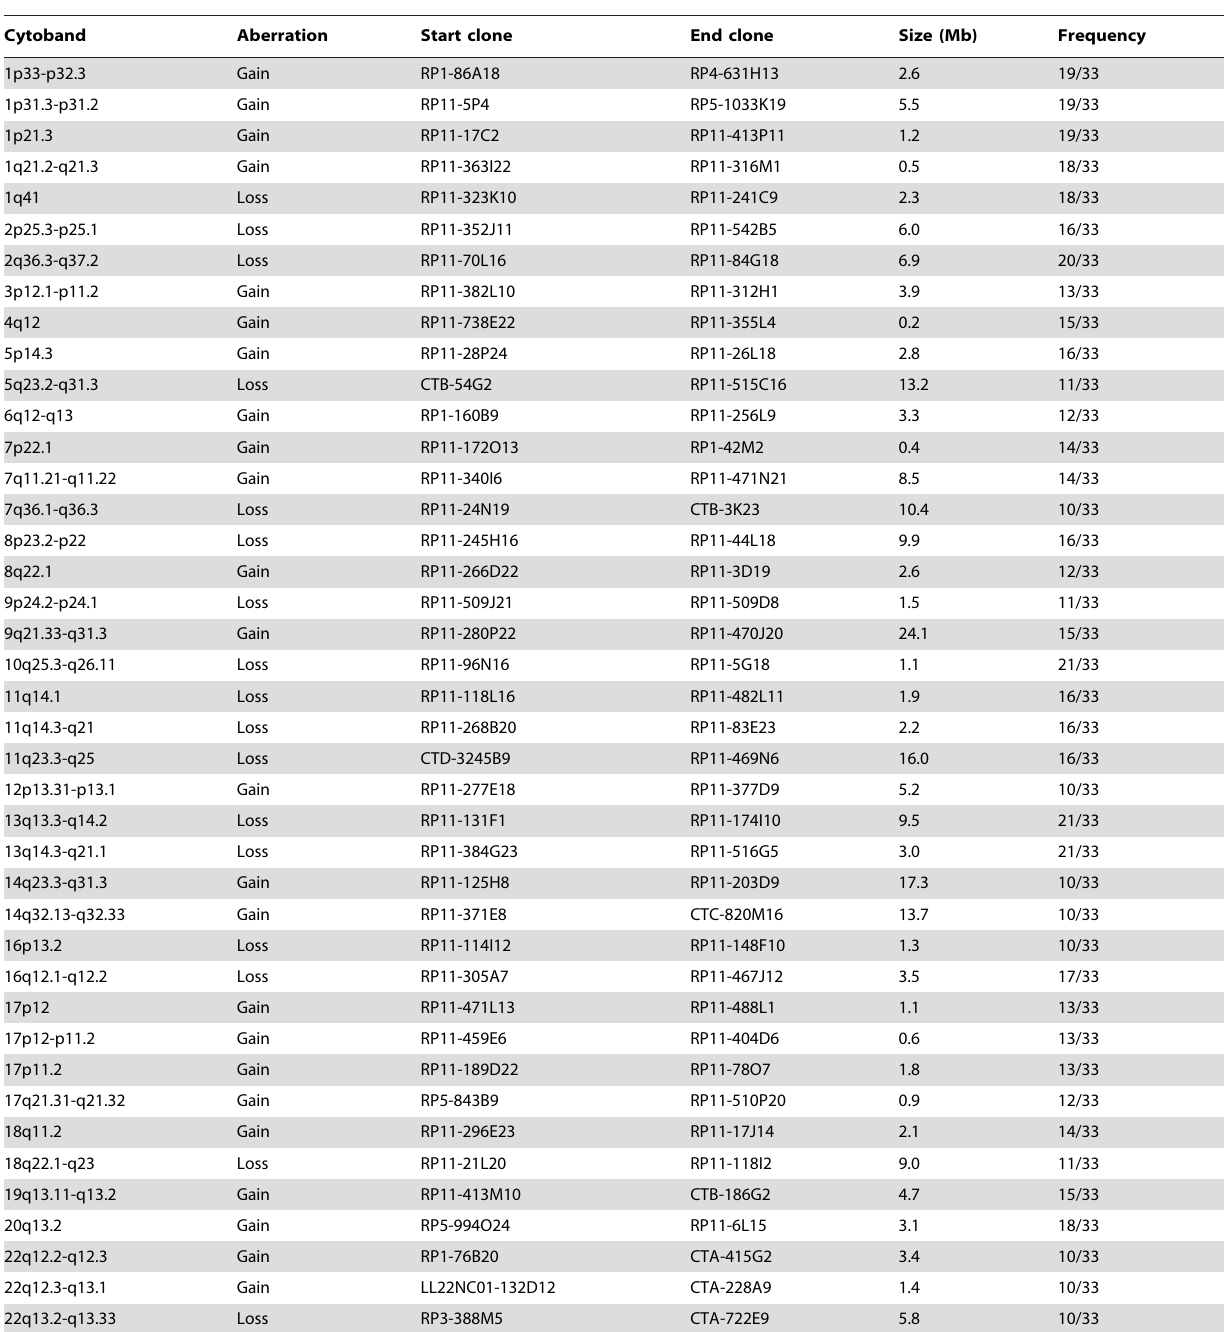
Table 2. Minimal recurrent regions altered in malignant fibrous histiocytomas (n=33).